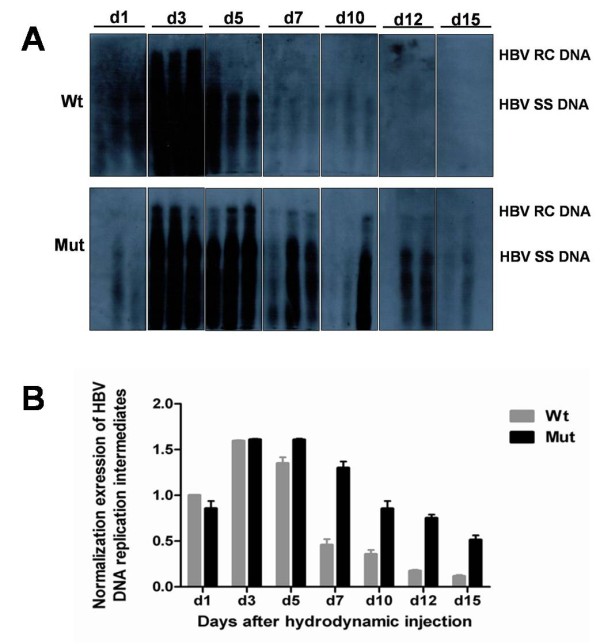
Time-dependent viral replication after hydrodynamic transfection in vivo. Mice were injected hydrodynamically with 10μg pHBV4.1 (Wt) or pHBV rt A181T/sW172 (Mut) respectively, and were sacrificed at different time points. A: HBV DNA replication intermediates of mice livers were detected by Southern blotting. B: Quantitative analysis of HBV DNA replication intermediates. The levels of HBV DNA replication intermediates in Wt group on day 1 were defined as 1.